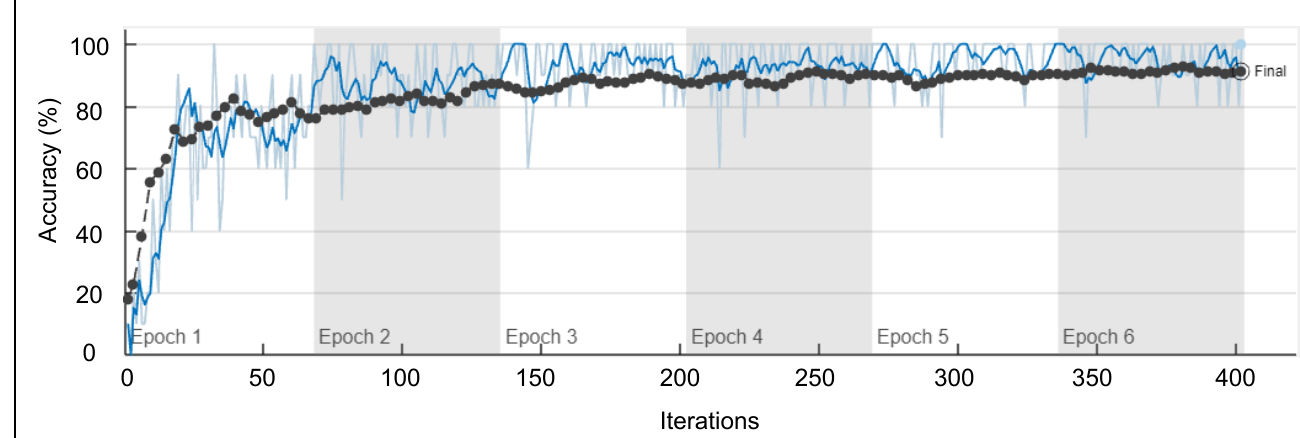
Figure 16. Classification of Iris image before and after encryption.